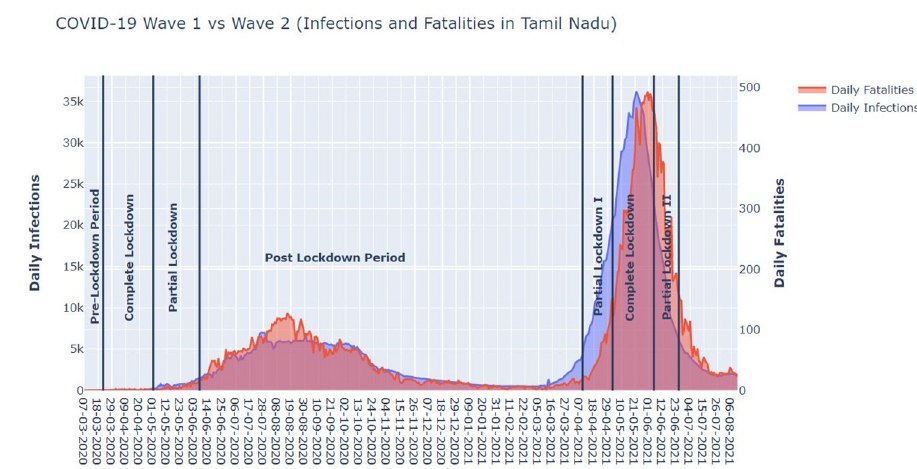
Fig 2. Graph of daily number of infections (Y-axis–Left in thousands) and fatalities (Y-axis-Right) during two waves of pandemic (X-axis day timeline).